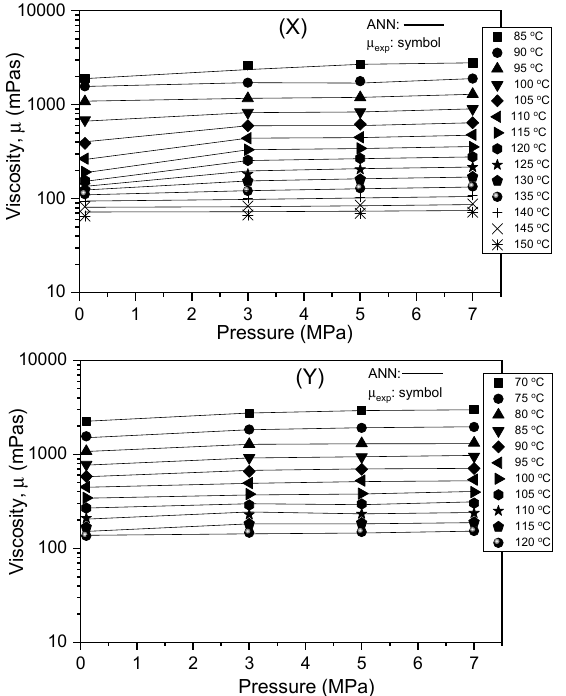
Figure 8. Experimental and calculated viscosities using the ANN model.